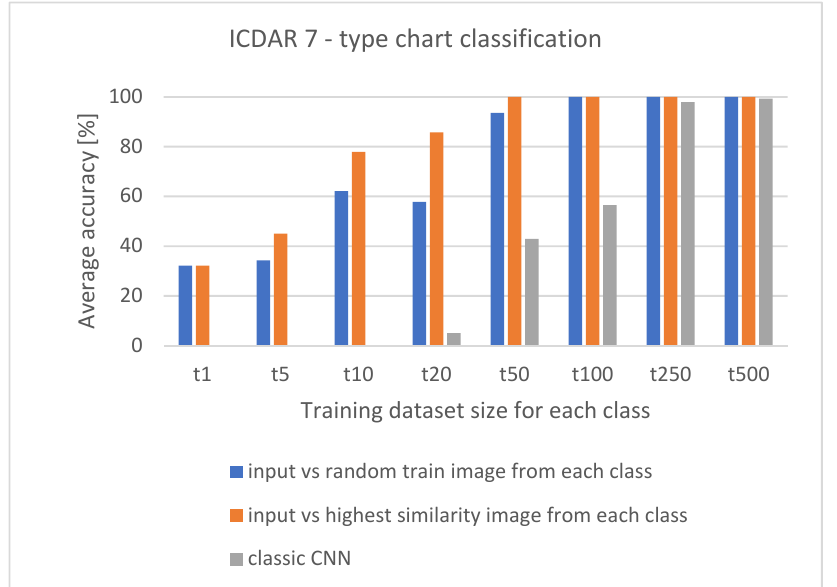
Figure 7. The summary of the average classification accuracy from Table 8. Between t10 and t20, the hit-or-miss effect can be seen. The state-of-the-art results for Siamese CNN are achieved with 50 training images per class.